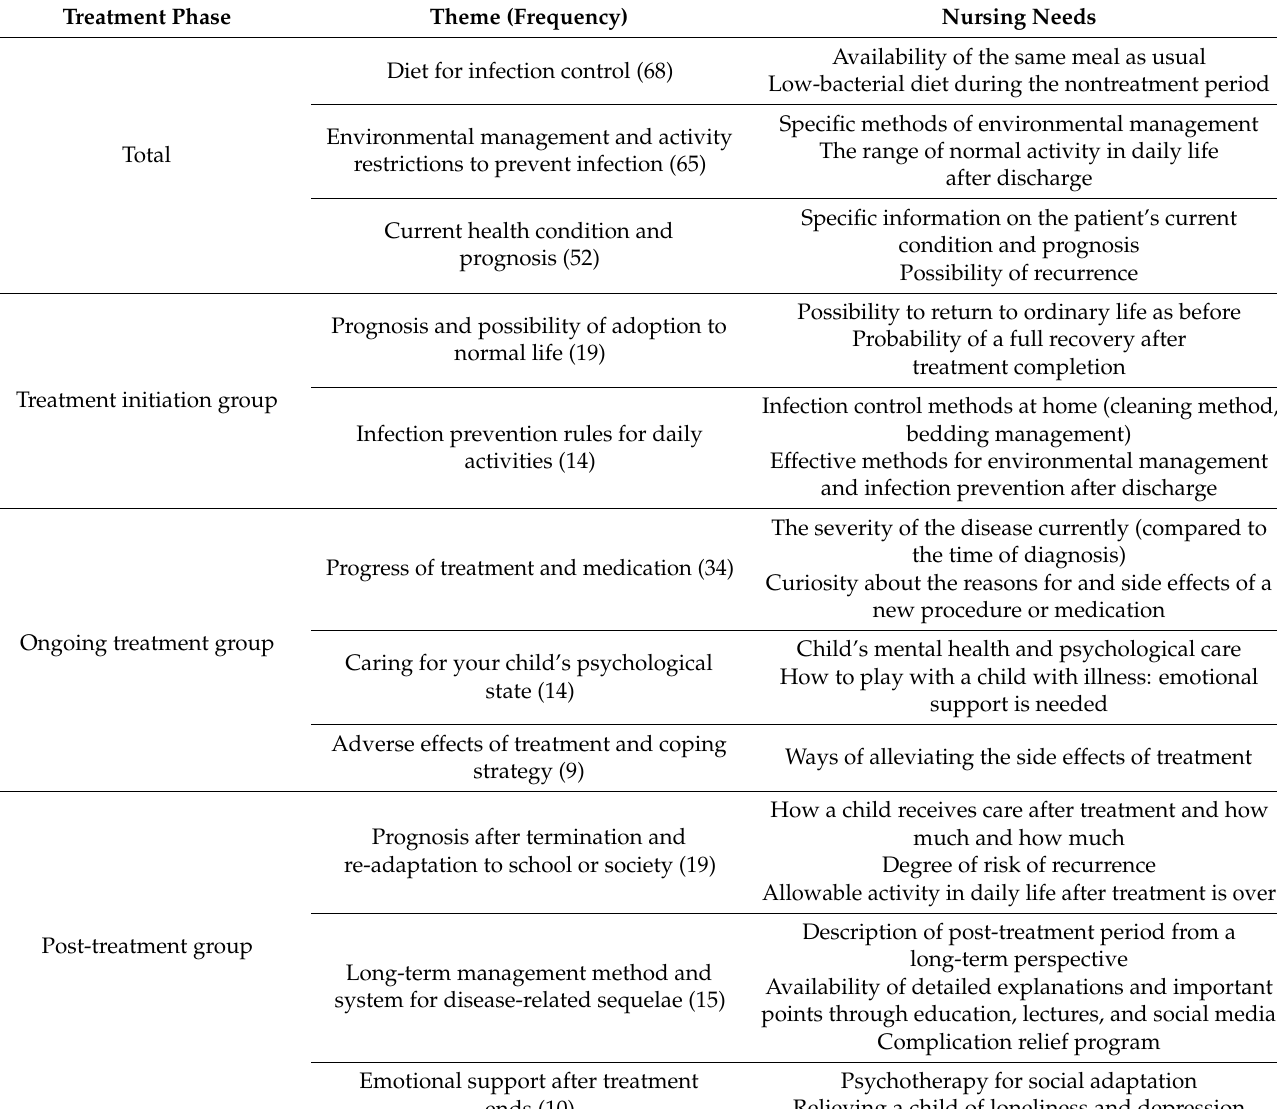
Table 5. Uncertainty-related themes described by participants according to the treatment